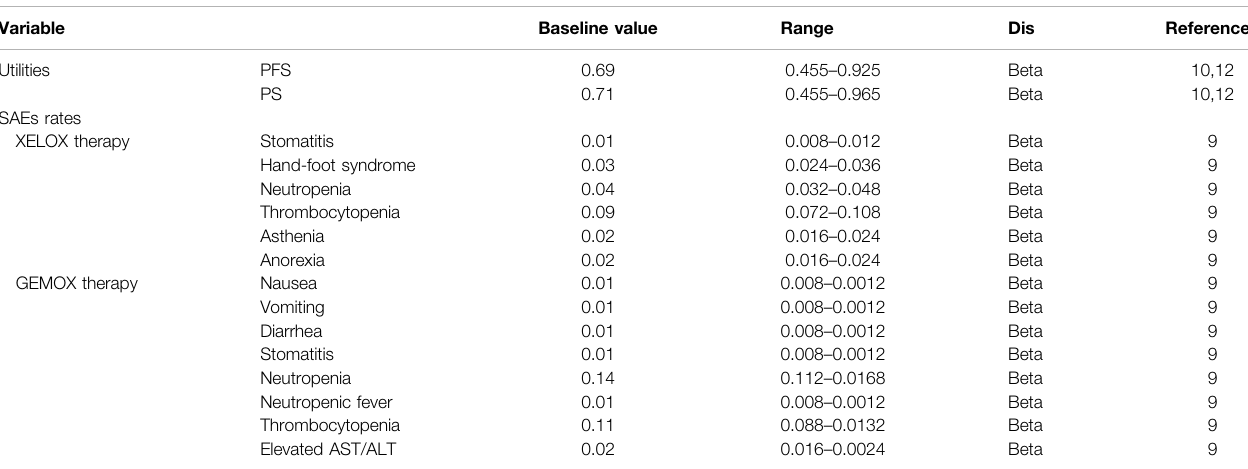
TABLE 2 | Ranges and distribution of other parameters.